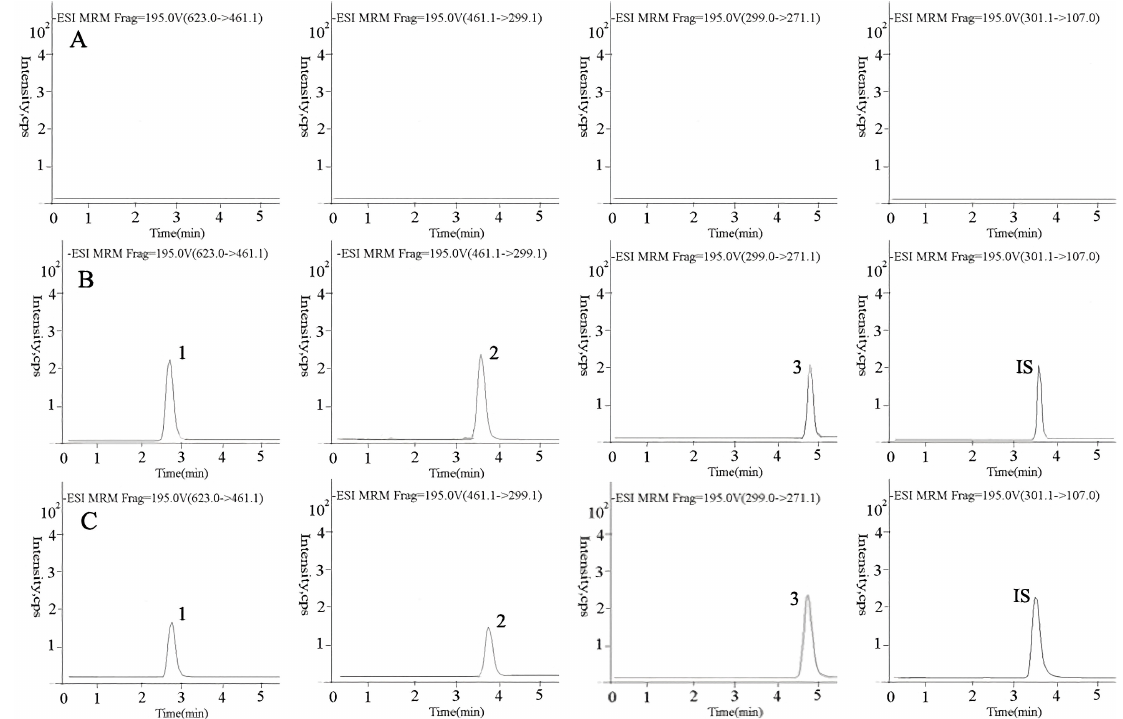
Figure 4. Representative multiple reaction monitoring (MRM) chromatograms of analytes in blank plasma samples ( A ); blank plasma samples spiked with the internal standard ( B ); the real plasma samples ( C ). (1) Complanatuside, (2) rhamnocitrin 3- O - β -glc, (3) rhamnocitrin, and (IS) quercetin. ESI: electro-spray ionization; IS:internal standard.